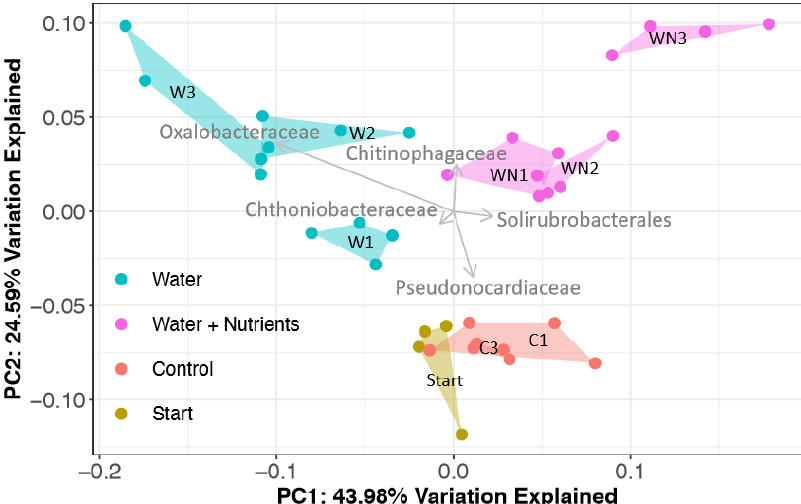
Figure 5. Principal coordinate analysis (PCoA) ordination plot of bacterial communities in soil microcosms. Repeated water additions to water- and nutrient-amended microcosms exposed to freeze–thaw cycles significantly changed the bacterial community (Permutational Multivariate Analysis of Variance (PERMANOVA) p < 0.001, R 2 = 0.74). The vector length is proportional to the correlation between the PCoA axes and the OTUs that contributed most to the observed dissimilarity among treatments (Similarity Percentage analysis, SIMPER). Communities became increasingly different from controls following multiple amendments.